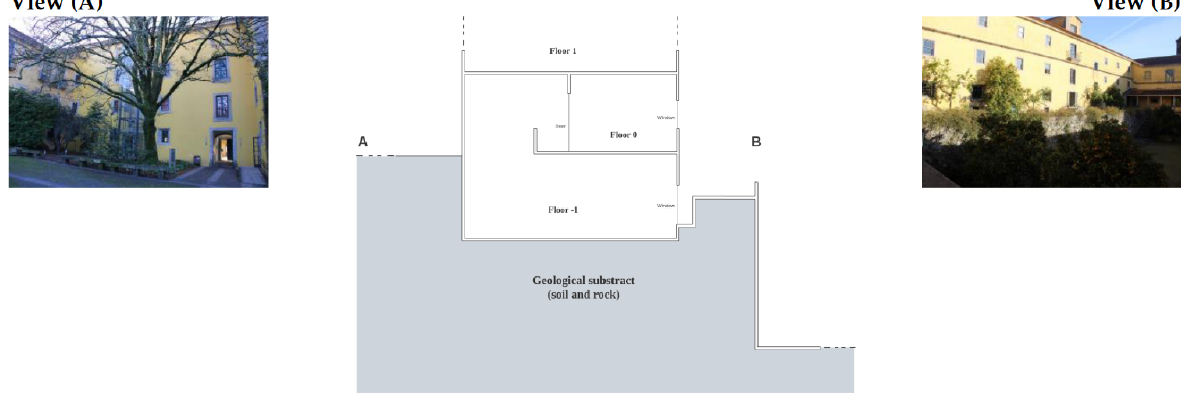
Figure 2. Section of the implantation of the building on the geological substratum. Views from each side of the main academic building of ESA IPVC, where view ( A ) refers to the main entrance of the building, exposed to the N, and view ( B ) presents the opposite facade, exposed to the S, where it is visible the difference of six meters between Floor ‐ 1 and the inner patio.